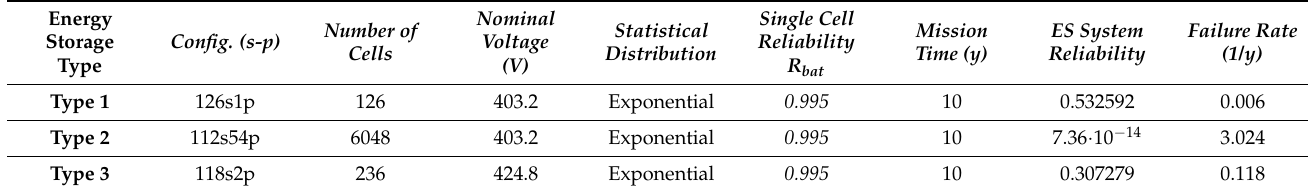
Table 2. Reliability analysis of different types of ES Types